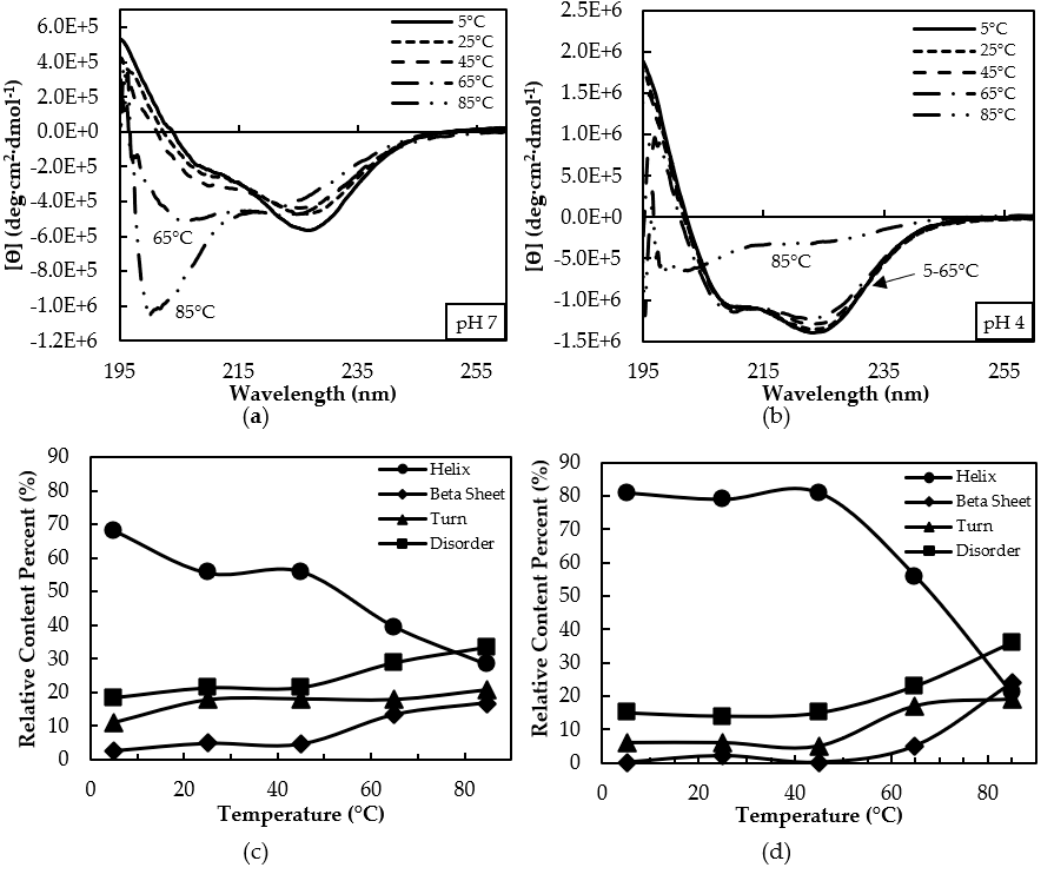
Figure 3. ( a ) Circular dichroism (CD) versus temperature at pH 7. ( b ) CD versus temperature at pH 4. ( c ) Secondary structure versus temperature at pH 7. ( d ) Secondary structure versus temperature at pH 4.